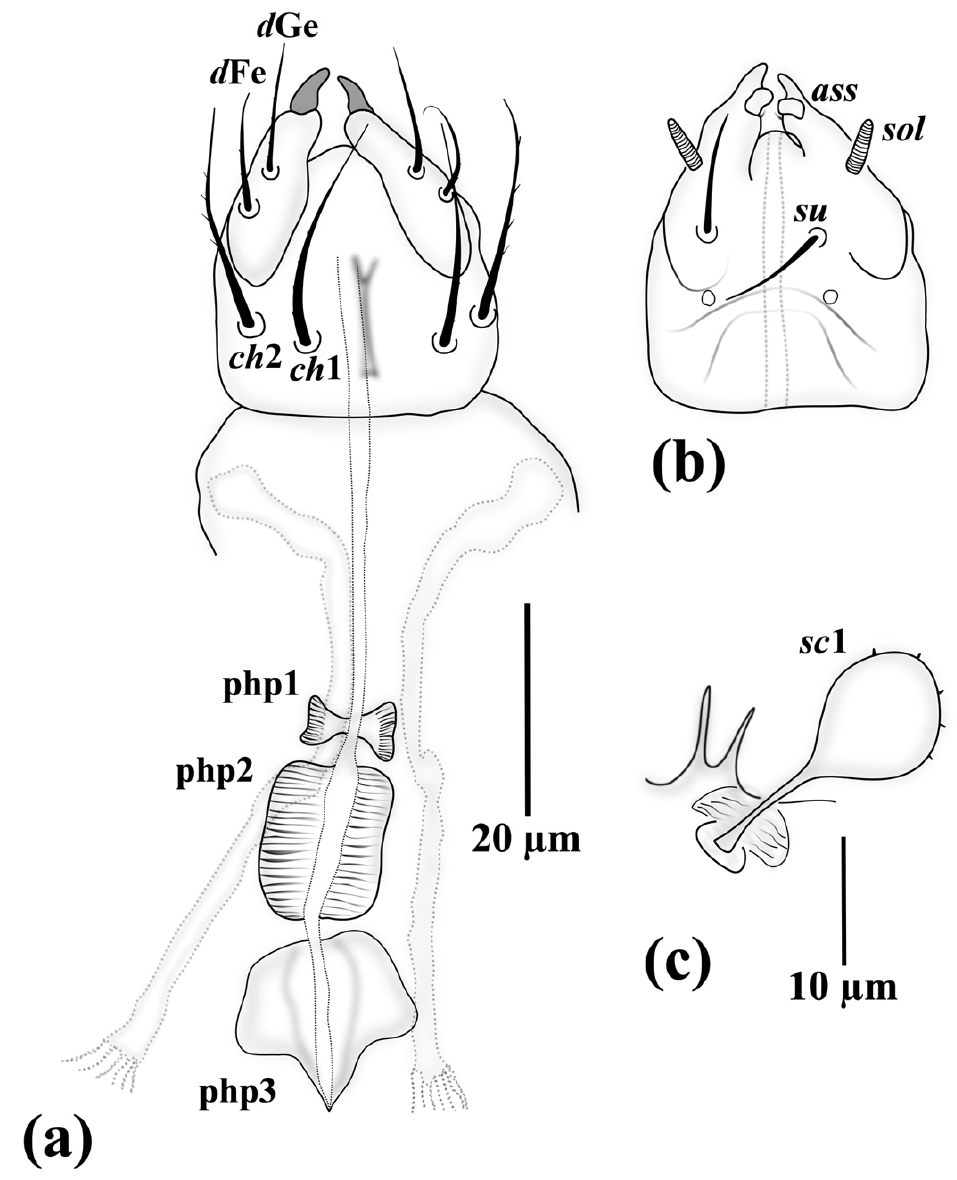
Figure 5. Archidispus hydrophilus sp. nov. ( a ) dorsal view of gnathosoma; ( b ) ventral view of gnathosoma; ( c ) seta sc 1.